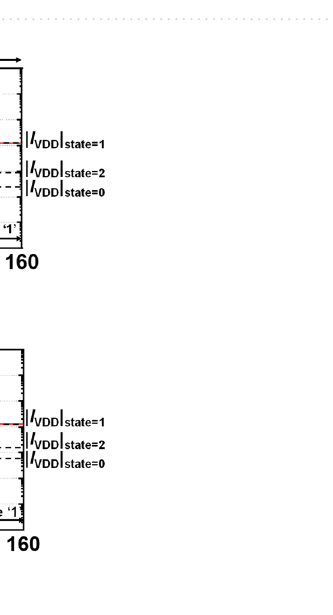
Figure 5. The C gg - V dG characteristics of ICDG (a) NMOS and (b) PMOS depending on gate length ( L G ) reduction. I on, ‘1’ and C gg of ICDG (c) NMOS and (d) PMOS according to gate length reduction.